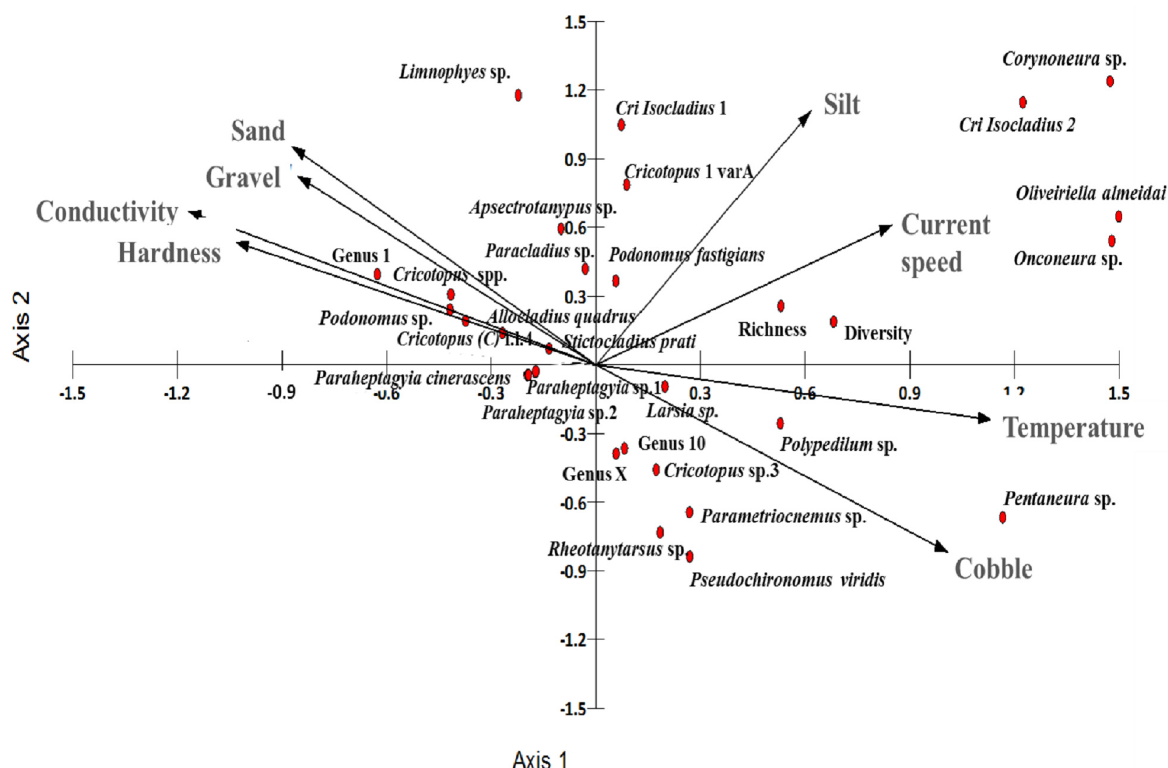
Figure 5. Canonical Correspondence Analysis (CCA) between Chironomidae species and environmental variables in the seven reaches of Chaco Serrano and Puna